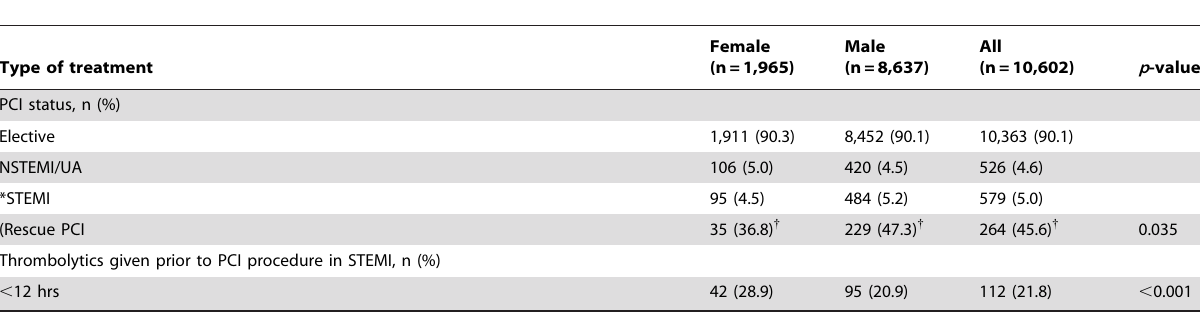
(ACS) had worse in-hospital and long term prognoses then men. Data from the Global Registry of Acute Coronary Events (GRACE) [13], a large, multinational, observational study on patients with acute coronary syndrome who underwent coronary angiography showed that women were older than men and had higher rates of cardiovascular risk factor. Women were twice as Table 2. In-patient clinical care by gender.